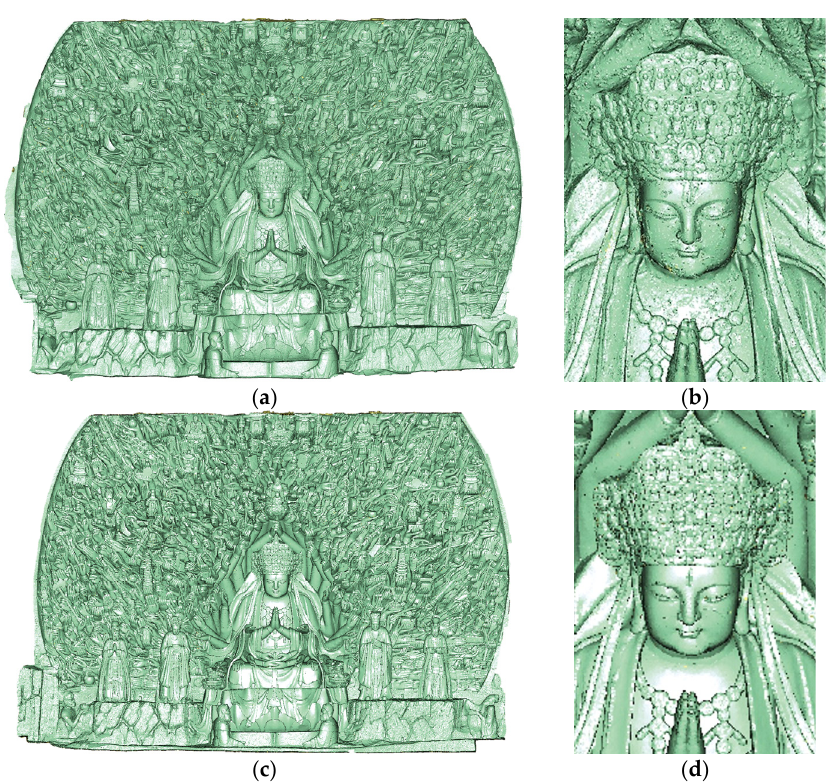
Figure 5. LOD0—The macro-scene in which the cultural relic is located was collected in 2015. A visualized 3D model was created by Beijing Digsur Science and Technology Co., Ltd. (Beijing, China) using the oblique photogrammetry technique with UAV data. Data was collected by UAVs, and dense point clouds were generated by oblique photography. Triangular mesh models were then constructed with textures.